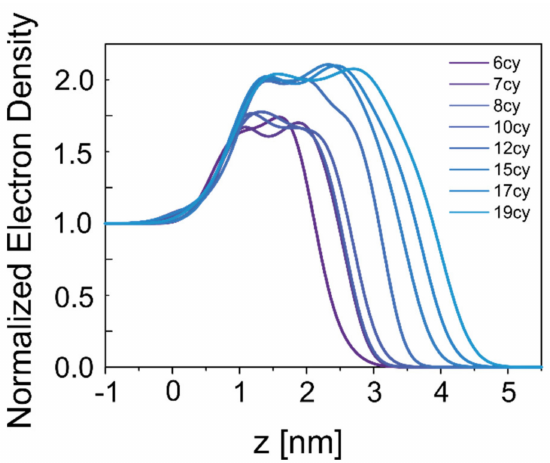
Figure 3. Normalized electron density profiles of a selection of XRR data as a function of the distance from the substrate. The electron density profiles were obtained with Stochfit.